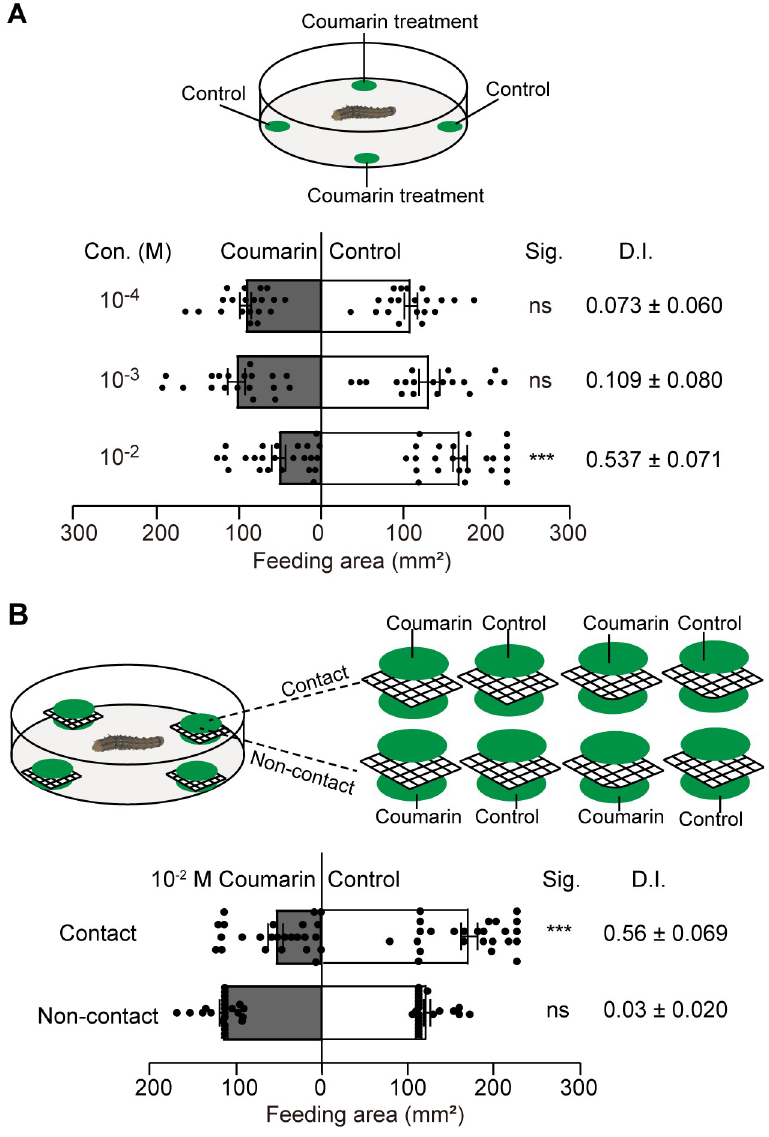
Fig 4. Feeding deterrence of the fifth instar Helicoverpa armigera larvae to coumarin by contact chemoreception. ( A ) Two-choice feeding assays with cowpea leaf discs: the feeding area of coumarin-treated discs (grey bars) and control discs (white bars) were measured (n = 19–20). ( B ) Modified two-choice feeding assays with ‘sandwich’ leaf discs: in the contact two-choice feeding assay, coumarin or control discs were painted on the upper leaf discs (n = 25); in the non-contact feeding assay, coumarin or control discs were painted on the lower leaf discs that prevented larvae from feeding (n = 24); the feeding area of the consumed upper leaf discs was measured. Feeding deterrence index (D. I.) = (consumed areas of the control discs—consumed areas of the treated discs) / (consumed areas of the control discs + consumed areas of the treated discs). Data are mean ± SEM. ��� and ns indicate significant difference (p < 0.001) and no significant difference (p > 0.05), respectively (two-tailed paired samples